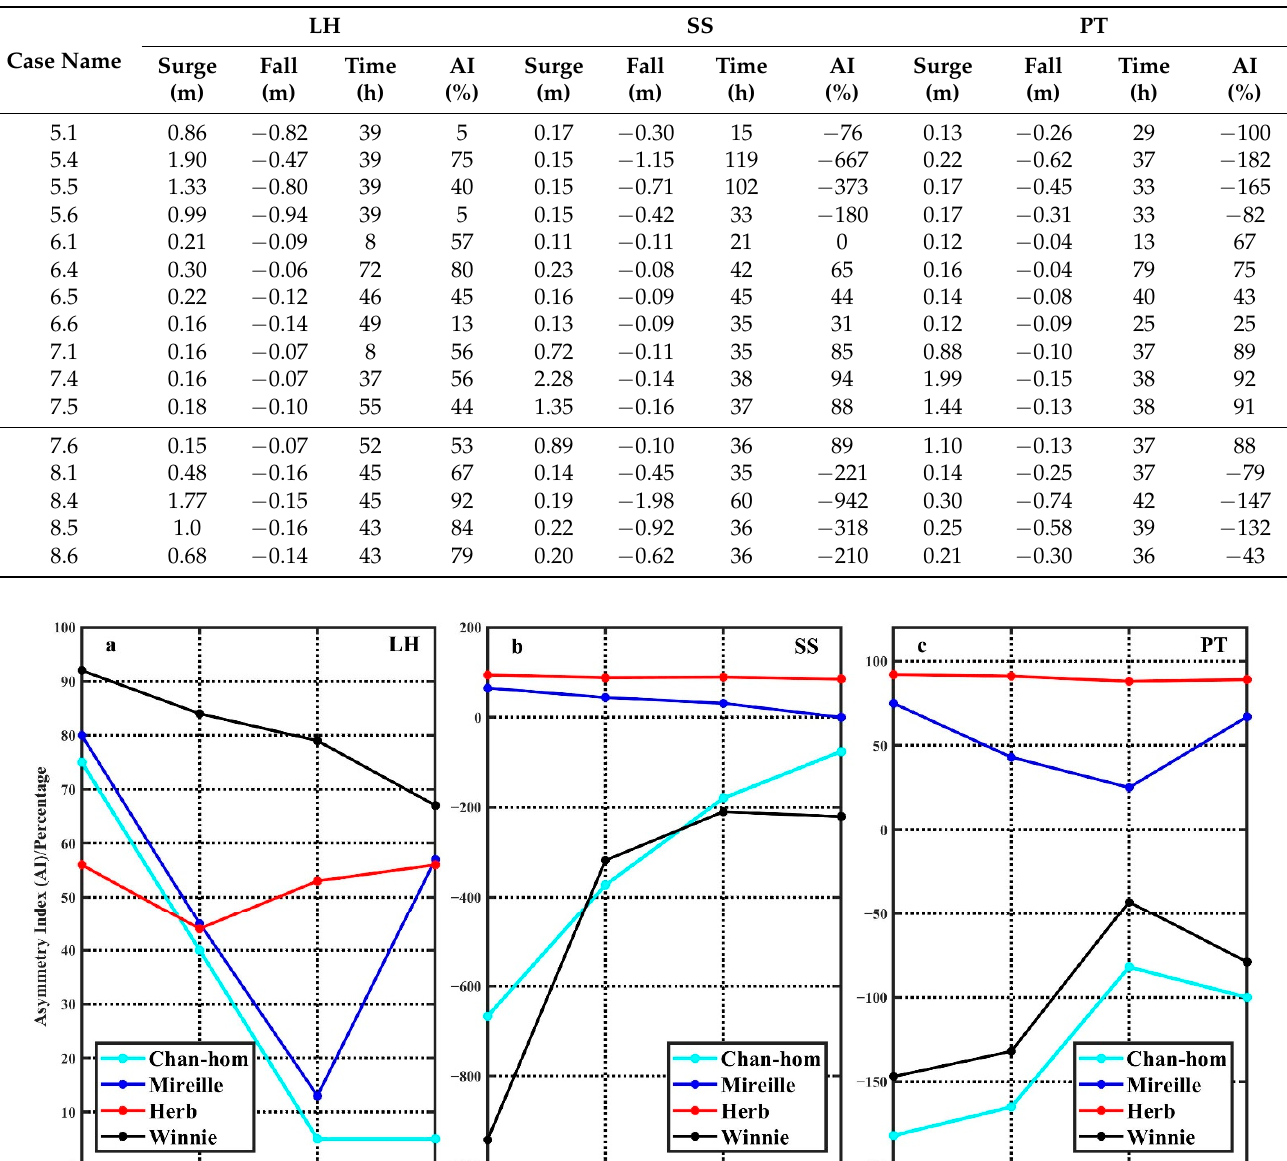
Table 9. The model results of surge, fall, time and the value of AI in sensitivity experiments with different topography at three stations (LH, SS, and PT). Surge (m): Surge max ; fall (m): Fall max ; time: occurrence time of surge reaches the peak (from a cold start); AI: asymmetry index.